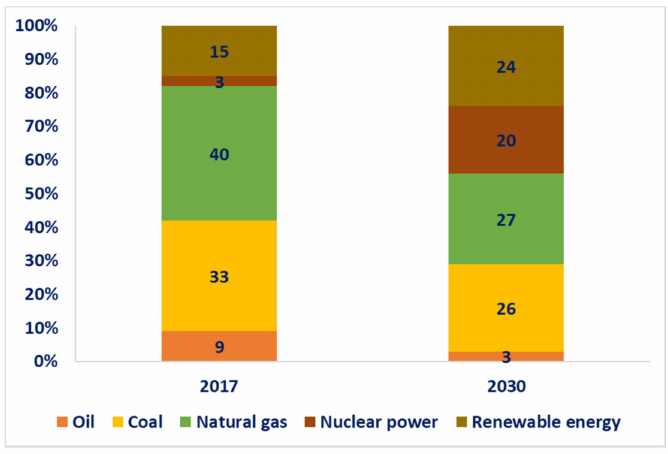
Figure 1. Japan’s energy mix outlook in 2030 (Adapted from